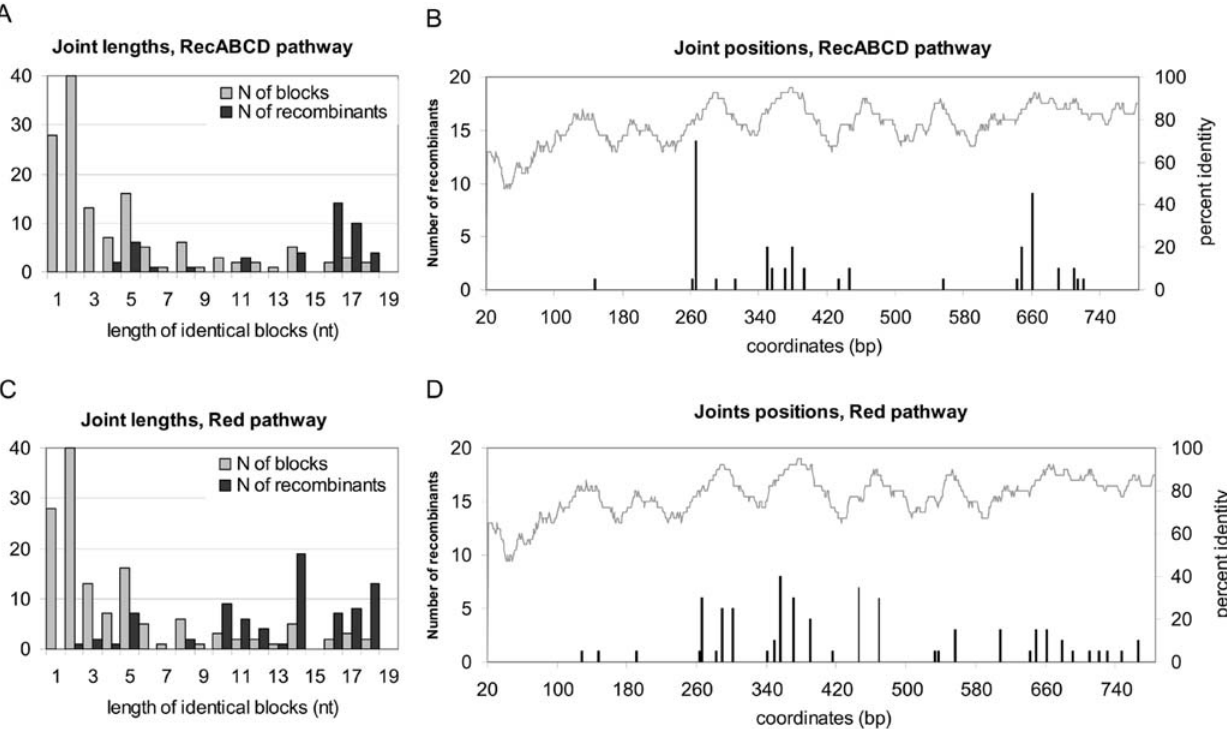
Figure 4. Sequence analysis of recombinant products between 22% diverged oxa. A and C: size distribution of the strictly conserved segments (blocks) of the oxa7/oxa5 alignment (see figure S1, panel B, for the alignment), and number of joints in each size category for recombinants formed in the RecABCD (A) or the Red (B) pathway. B and D: Positional organisation of the joints formed in the RecABCD (B) or the Red (D) pathway along the oxa ORF alignement, 1 is the start position. The upper curve (and the rightward y axis) describes the local percentage of identity along the two sequences, using a sliding window of 40 bp.